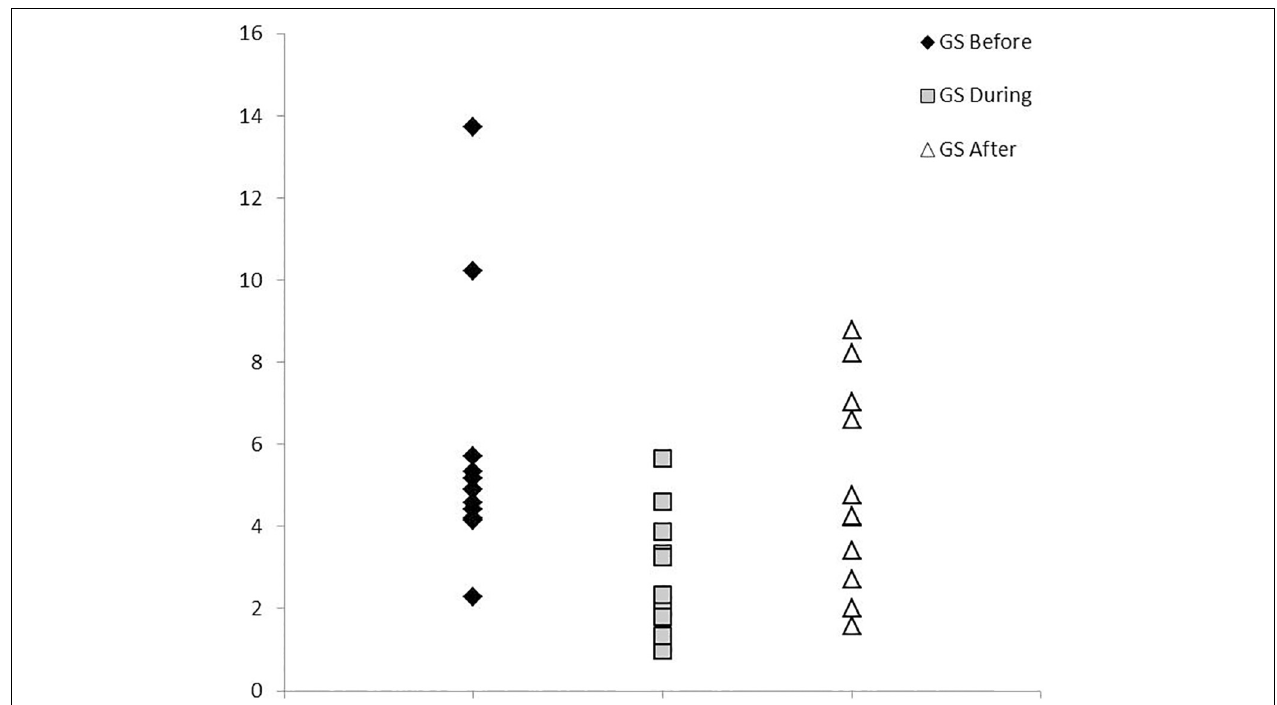
FIGURE 3 | Group size. Average group size for Sarasota Bay cases before injury, during injury, and post-rescue ( n = 12). Group size while injured was significantly smaller than either the year before injury or after intervention, which did not differ from each other.